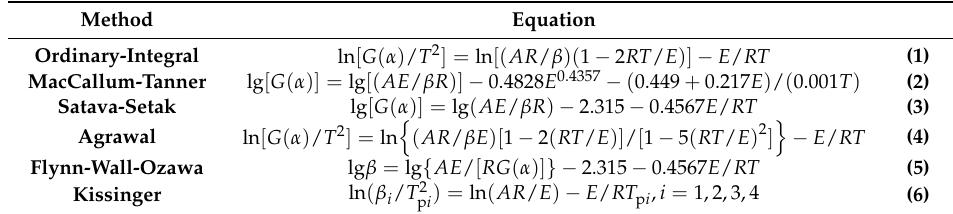
Table 1. Kinetic analysis methods.